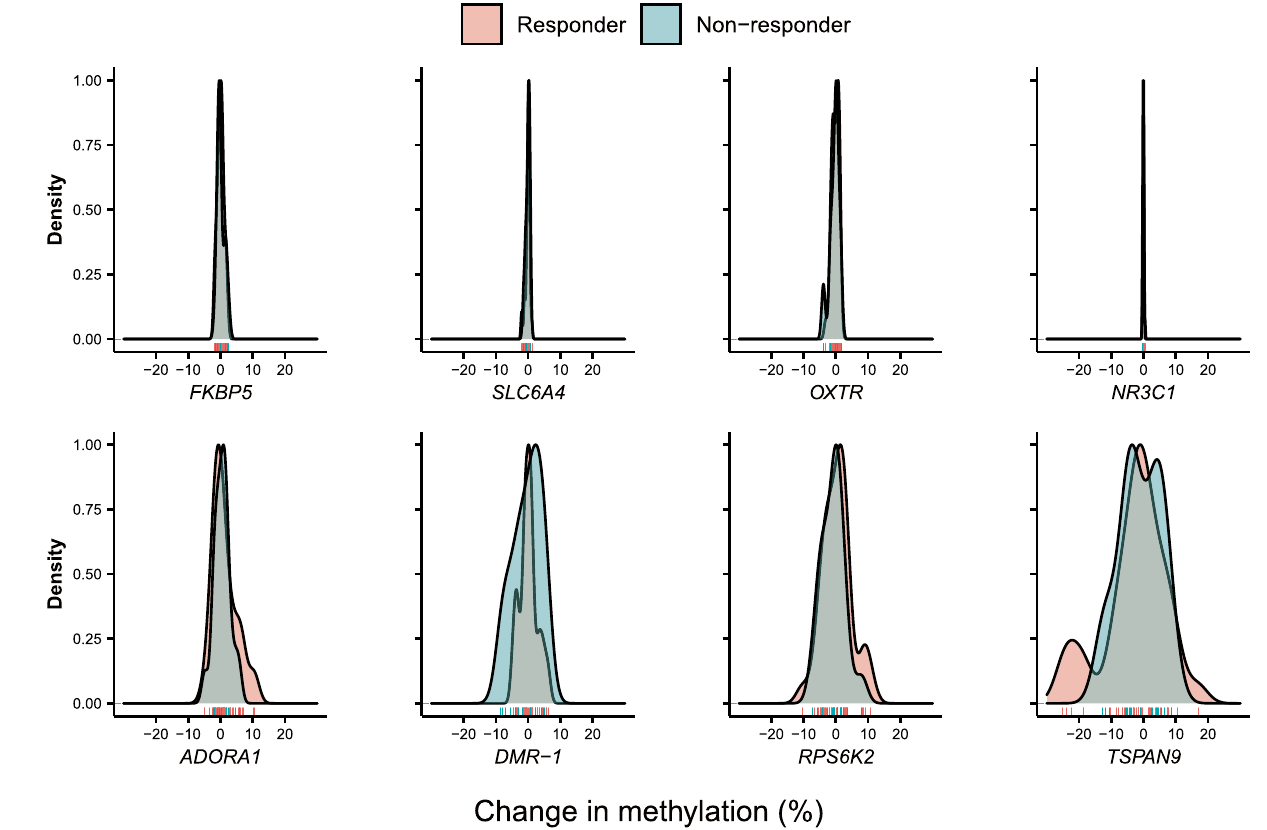
Figure 1. Density plots for the distribution of DNA methylation change (post minus pre-treatment) by therapy response and gene. The top row pictures the candidate genes and the bottom row the new targets from the WGBS analysis. The Y-axis shows the density and the X-axis the mean DNA methylation change in percent (%). The red curve displays the responders and the green curve the non-responders. The individual patients are depicted as red and green lines on the